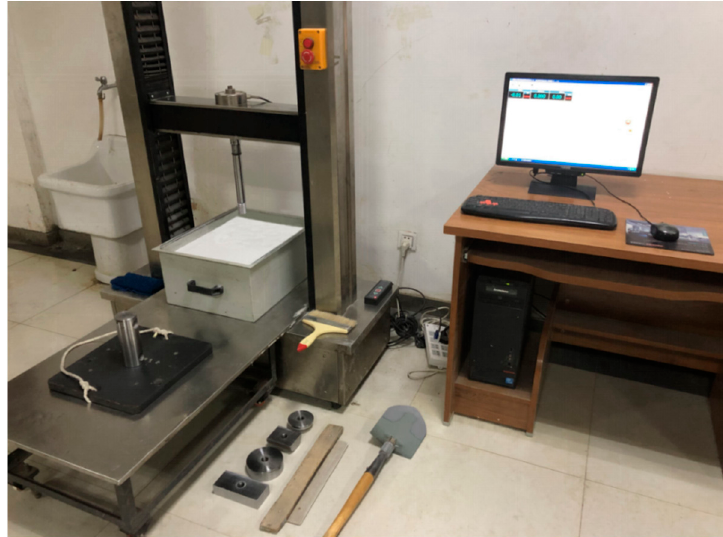
Figure 4. Intrusion test devices.